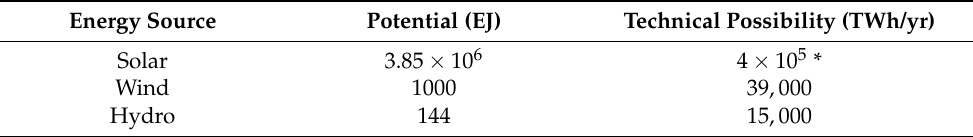
Figure 2. Odum’s diagram based on the type of energy availability and usage. (This conceptual image is re-drawn based on the cited reference.) Table 1. Potential and technical possibility of significant renewable energy sources